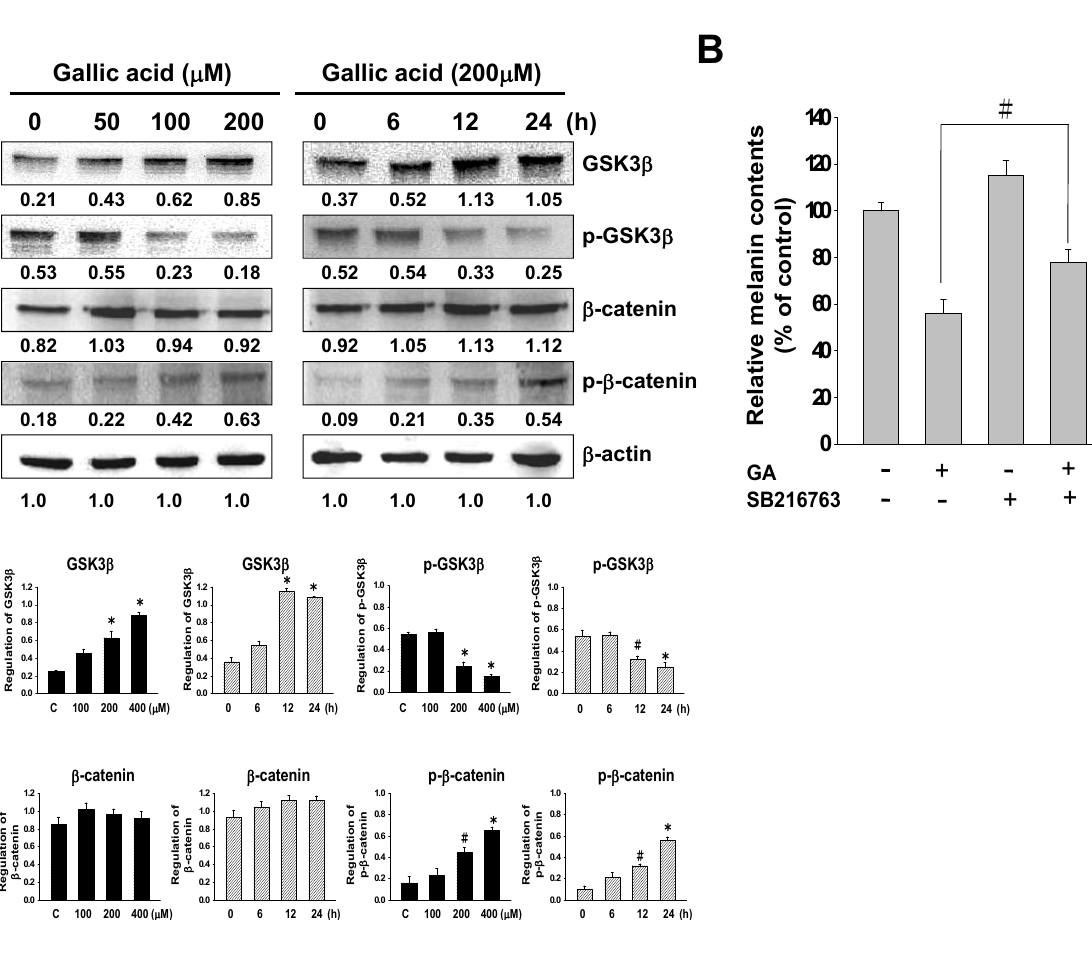
Figure 6. The expressions of Wnt/ β -catenin related-proteins in B16F10 melanoma cells treated with gallic acid. ( A ) The Western blot assay results showed the changes in GSK3 β , p-GSK3 β , β -catenin, and p- β -catenin expressions in B16F10 melanoma cells treated with different concentrations of gallic acid (0–200 µM) for 24 h and treated with 200 µM of gallic acid at different times. β -Actin was used as the protein loading control. Statistical results represented as Means ± SEM ( n = 3) performed by ANOVA with the Tukey-Kramer test ( # p < 0.05, * p < 0.001 compared with the control); ( B ) The cellular melanin content was evaluated. These data are representative of three independent experiments ( # p < 0.05 compared with the